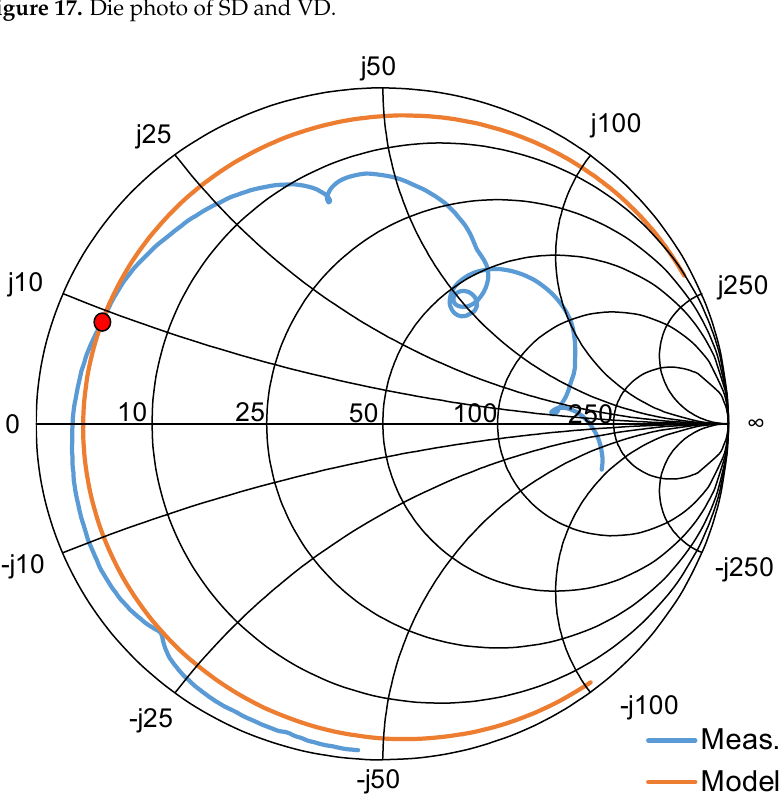
Figure 18. Input impedance of the evaluation board at the input frequency of 0.5 ∼ 1.5 .